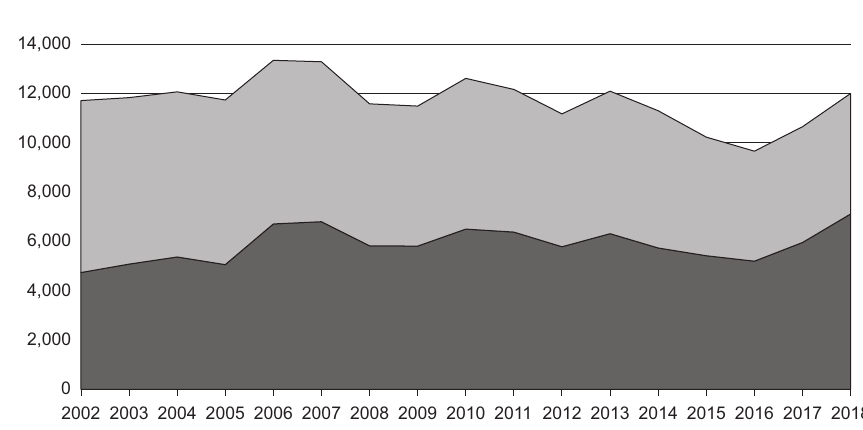
Fig. 2. Number of emigrants from Wrocław in the years 2002–2018 within and out of the city. Source: author’s own work based on the Demography